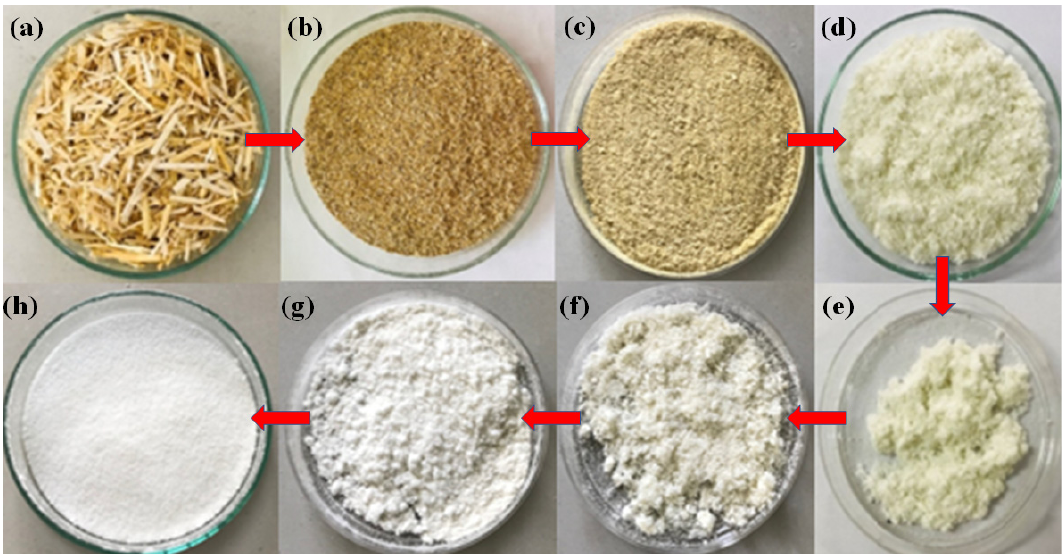
Fig. 2. (a) Raw wheat straw, (b) Grinded wheat straw, (c) Alkali treated, (d) First bleaching fibres, (e) Second bleaching fibres, (f) Final bleaching fibres, (g) Acid hydrolysis, (h)